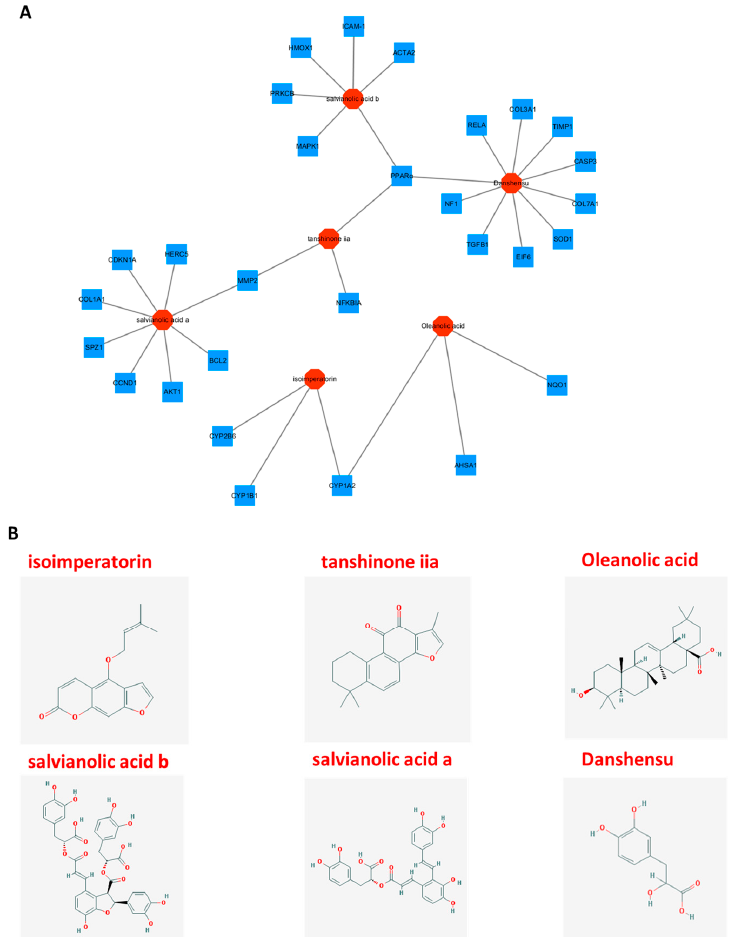
Figure 8. Compound–target networks and corresponding compound structures. The Compound-target network related to hepatoprotective effects in ALD and NALFD was shown in ( A ). The red octagons are active compounds from Danshen and the blue squares represent potential hepatoprotective target genes; the gray line represents the compound–target interaction; ( B ) The corresponding chemical structures of the six potential hepatoprotective components from Danshen.